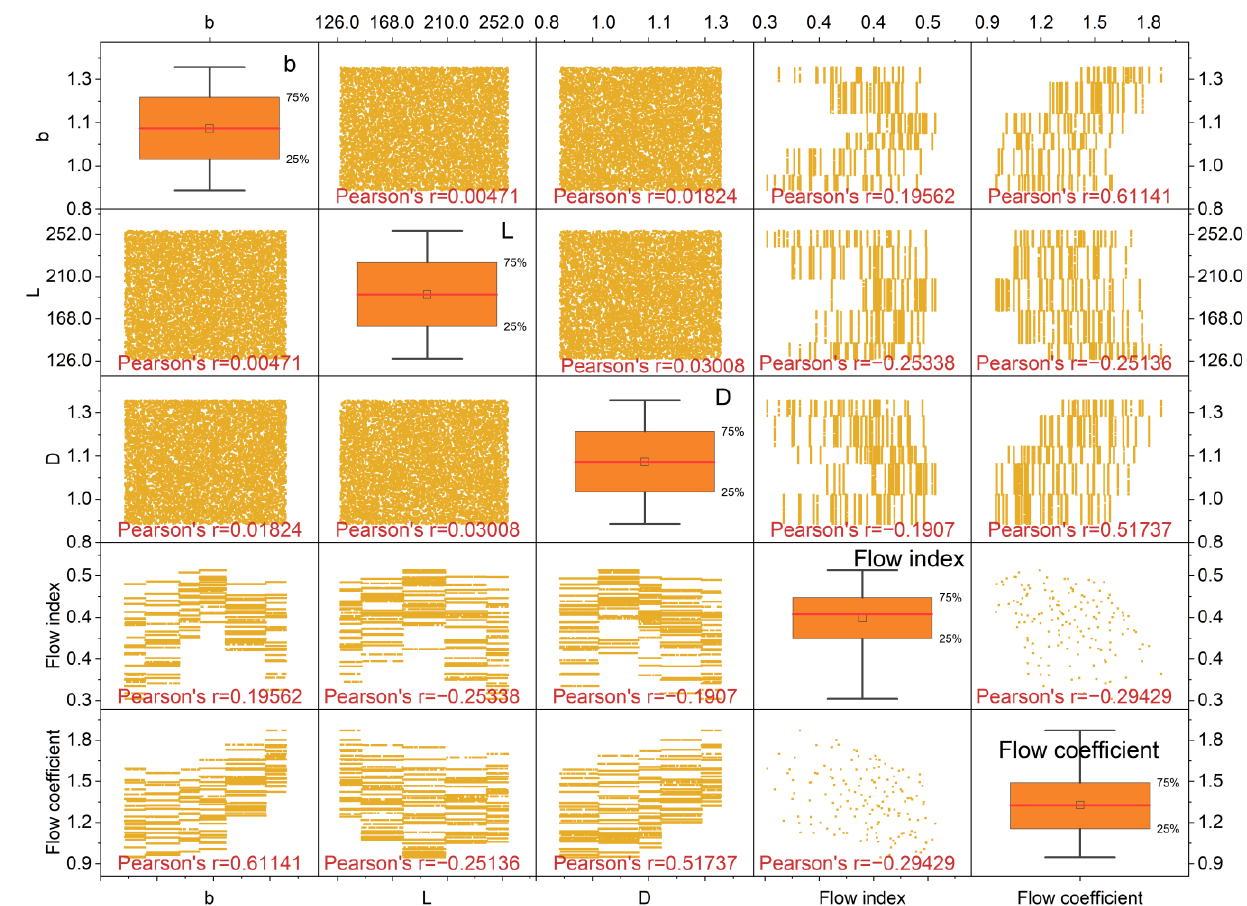
Figure 10. Analysis of transverse and longitudinal velocity field distribution and turbulence intensity characteristics of flow paths of different lengths.